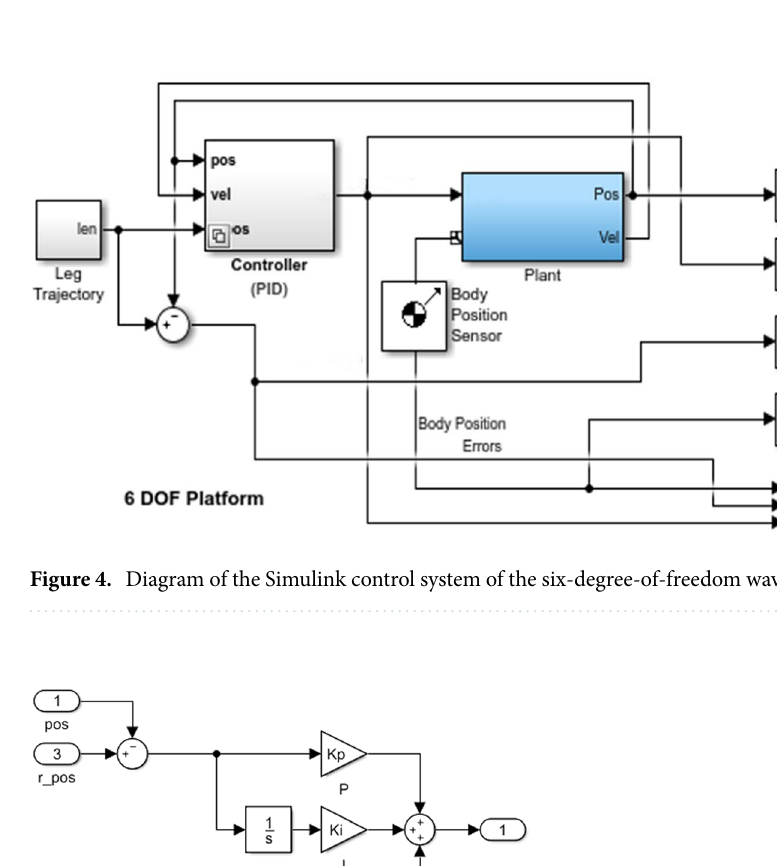
Table 1. The influence of PID parameters on the performance of wave compensation controller.